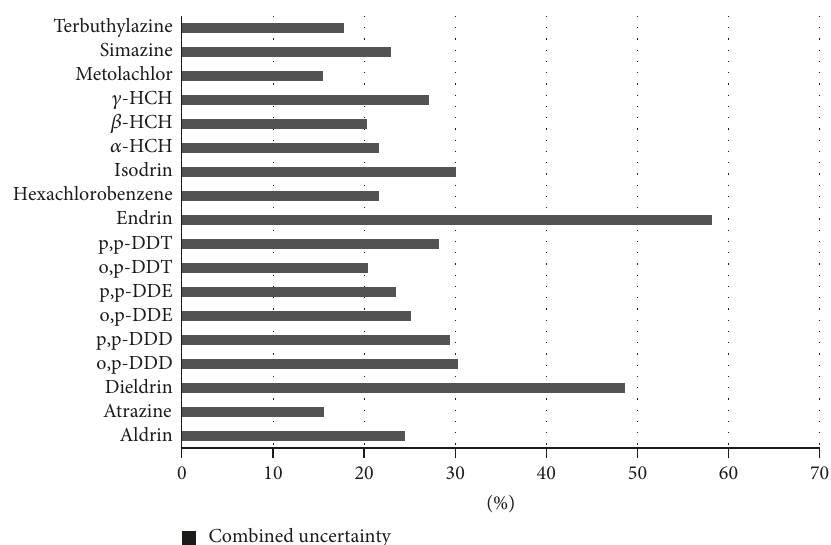
Figure 3: Combined uncertainty for the analysis of the selected pesticides in water